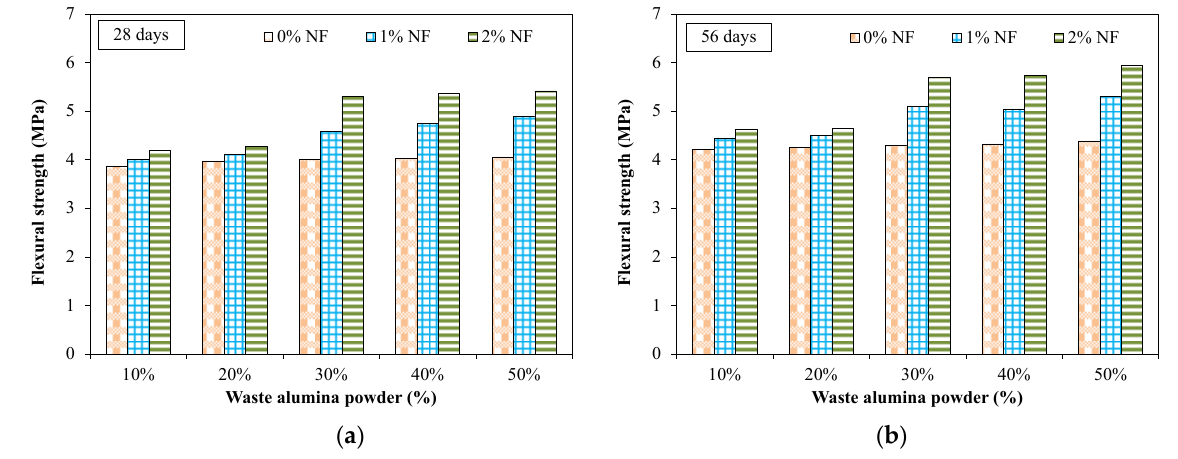
Figure 11. Effect of fibers on flexural strength specimens incorporating AP and fibers. ( a ) 28 days ( b ) 56 days.